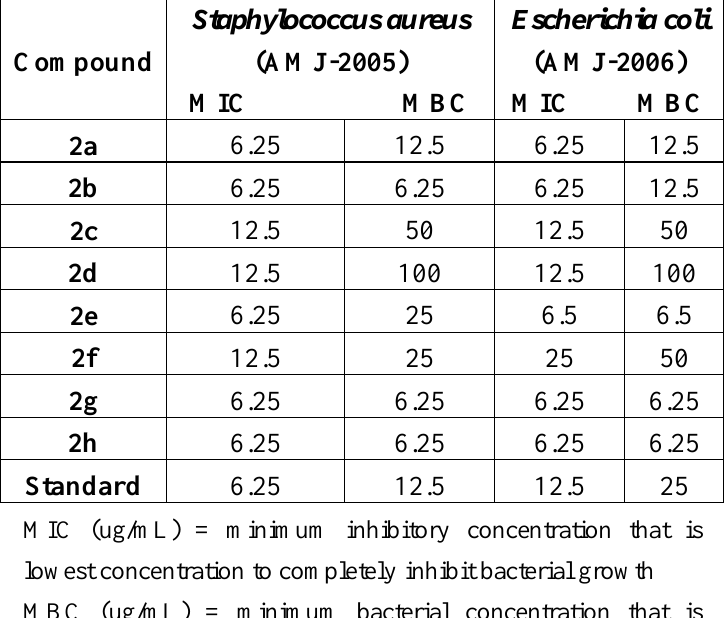
Table 2. MIC and MBC results of azomethine